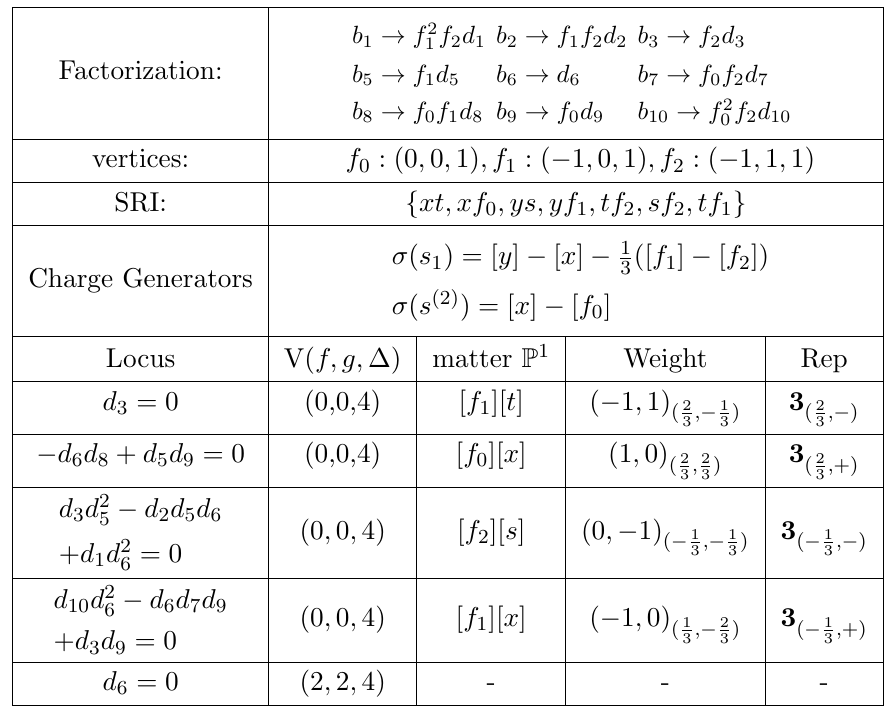
Table 18 . Summary of SU(3) top